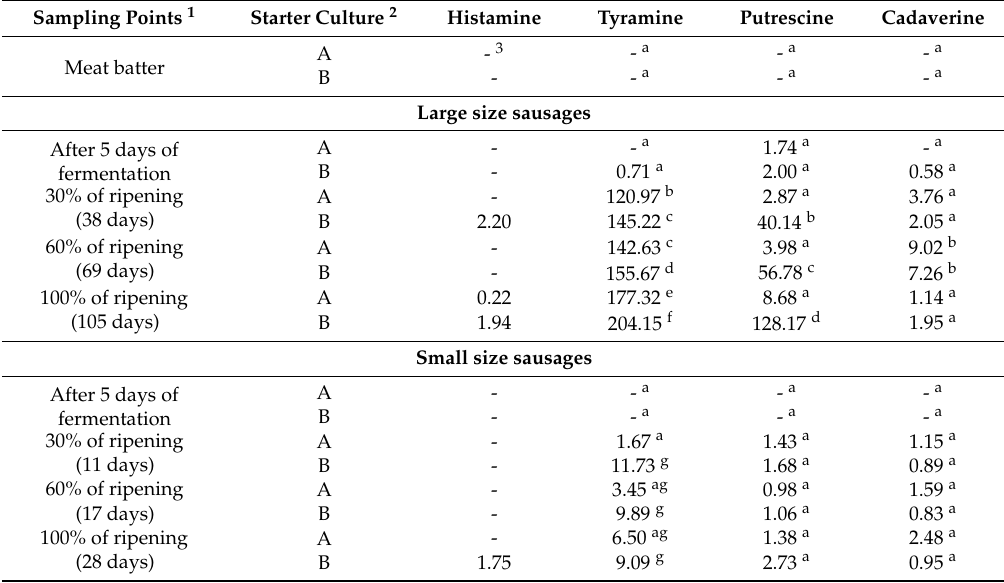
Table 1. Biogenic amine content (mg/kg) of the samples during fermentation and ripening. Sampling Points